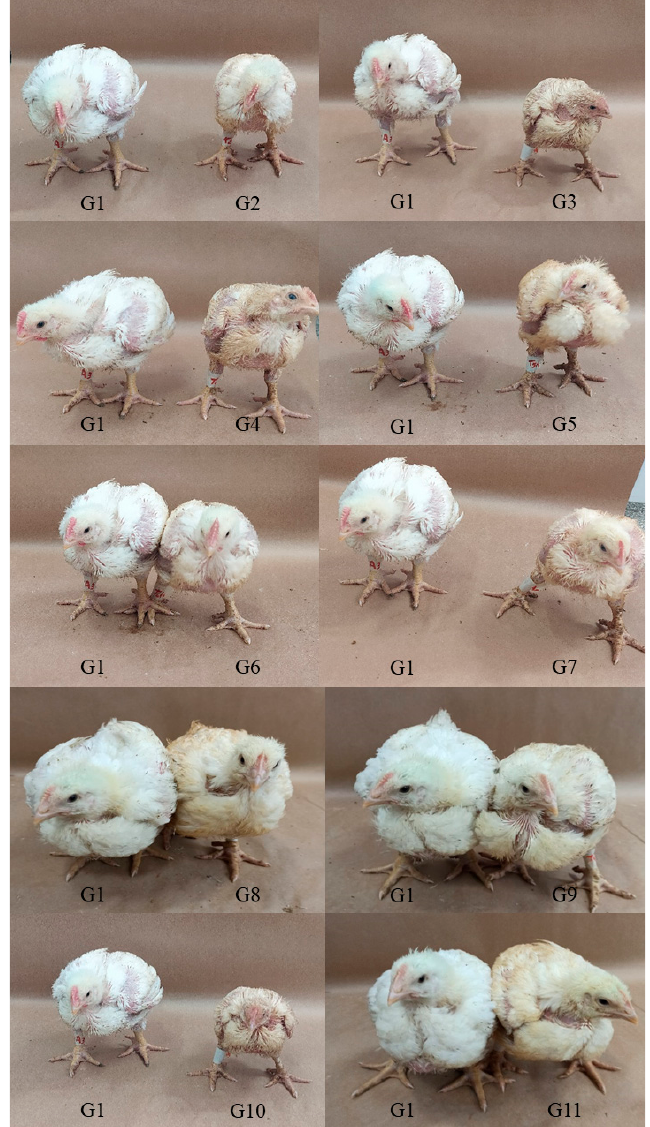
Figure 1. Presence of nonuniformity between the groups in relation to the negative control. G1— negative control; G2—CP13 + Eimeria spp.; G3—CP13 + IBDV-vac; G4—CP13 + Eimeria spp. + IBDV-vac; G5—CP14 + Eimeria spp.; G6—CP14 + IBDV-vac; G7—CP14 + Eimeria spp. + IBDV-vac; G8—CP03 + Eimeria spp.; G9—CP03 + IBDV-vac; G10—CP03 + Eimeria spp. + IBDV-vac; G11— Eimeria